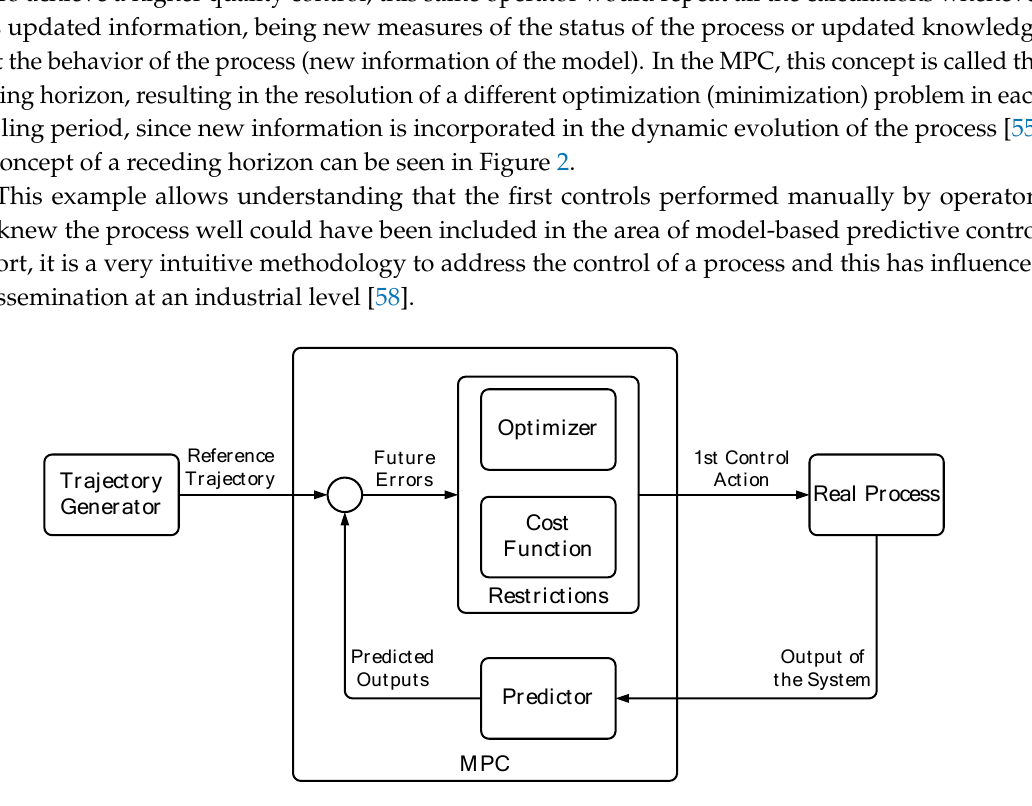
Figure 3. The strategy of the MPC. Future control actions are calculated in a way that minimizes a certain cost function. Thus, the cost function assigns a value to each prediction and therefore to each postulated control law. This